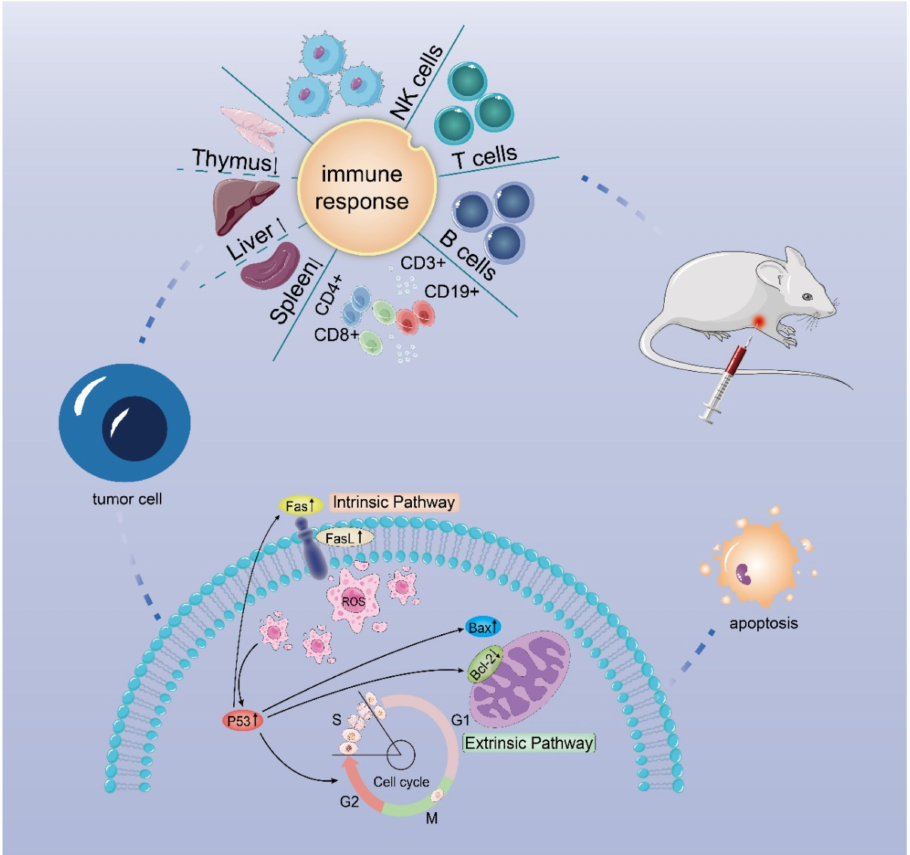
Figure 10. Possible mechanism of action of DLP120 in H22 tumor-bearing